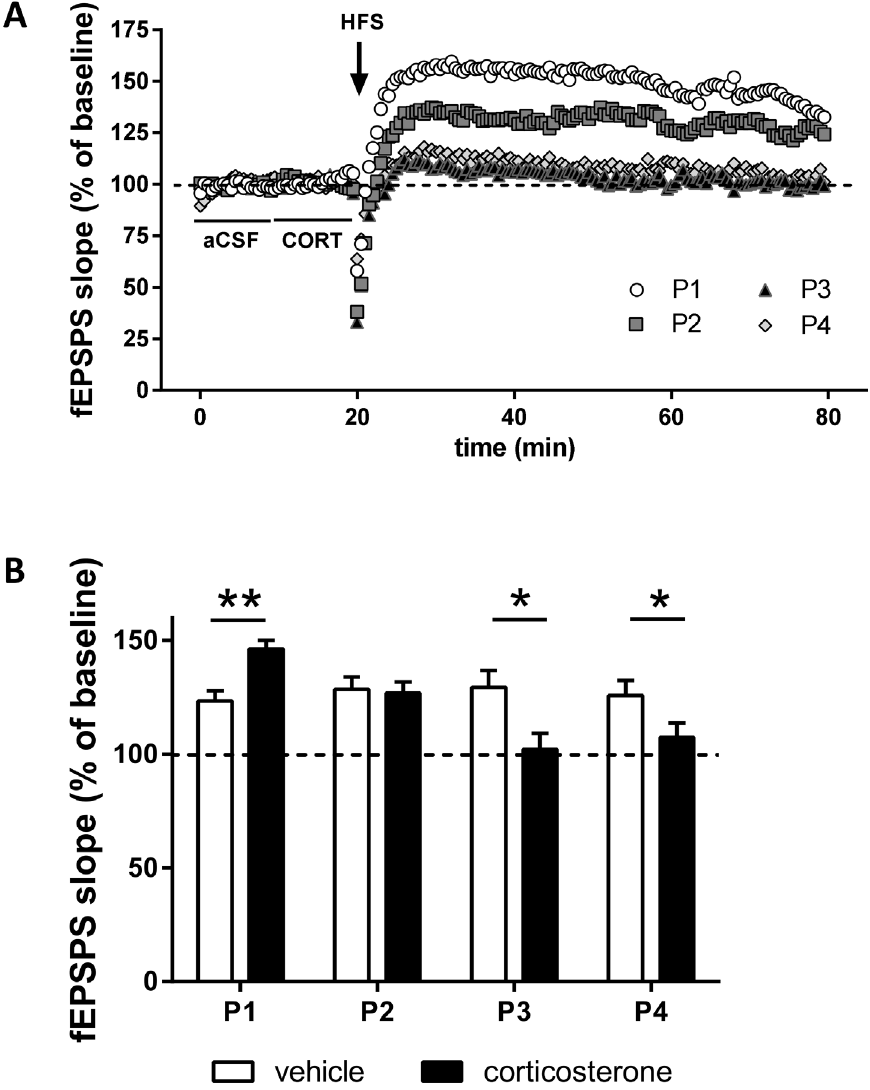
Fig 3. Consecutive corticosterone application attenuates hippocampal LTP. (A) Experimental design. Corticosterone (CORT, 100 nM) or its vehicle was applied for 10 min (thin horizontal arrow), followed by 50 min application of the standard recording buffer. This sequence was repeated four times. Baseline fEPSP properties were recorded 10 min prior to each pulse, during the pulse and up to 50 minutes after the pulse (bold vertical arrow). The fEPSP slope measured at this time point was compared with that recorded prior to the pulse and the relative changes are depicted in part C. Coinciding with the end of the CORT or vehicle pulse, high frequency stimulation (HFS) was applied to the slice (lightning bolt). HFS was delivered only once in each slice. Statistical analysis is described in the Methods section. (B) HFS (high-frequency stimulation) resulted in significant potentiation of synaptic responses, as seen in CA1 synapses of brain slices exposed to a corticosterone pulse (open circles). HFS applied during subsequent pulses resulted in attenuated LTP (P2 = grey squares, P3 = black triangles; P4 = grey diamonds; n = 7 – 9 for each pulse). Data represent mean ± SEM. (C) Averaged mean values during the 60-min post-tetanic recording period indicate the gradual attenuation in LTP after consecutive corticosterone pulses (black bars), while vehicle treatment did not affect synaptic plasticity over time (open bars). Values indicate group means ± SEM ( ** P < 0.01; * P < 0.05; n = 6 – 9 per